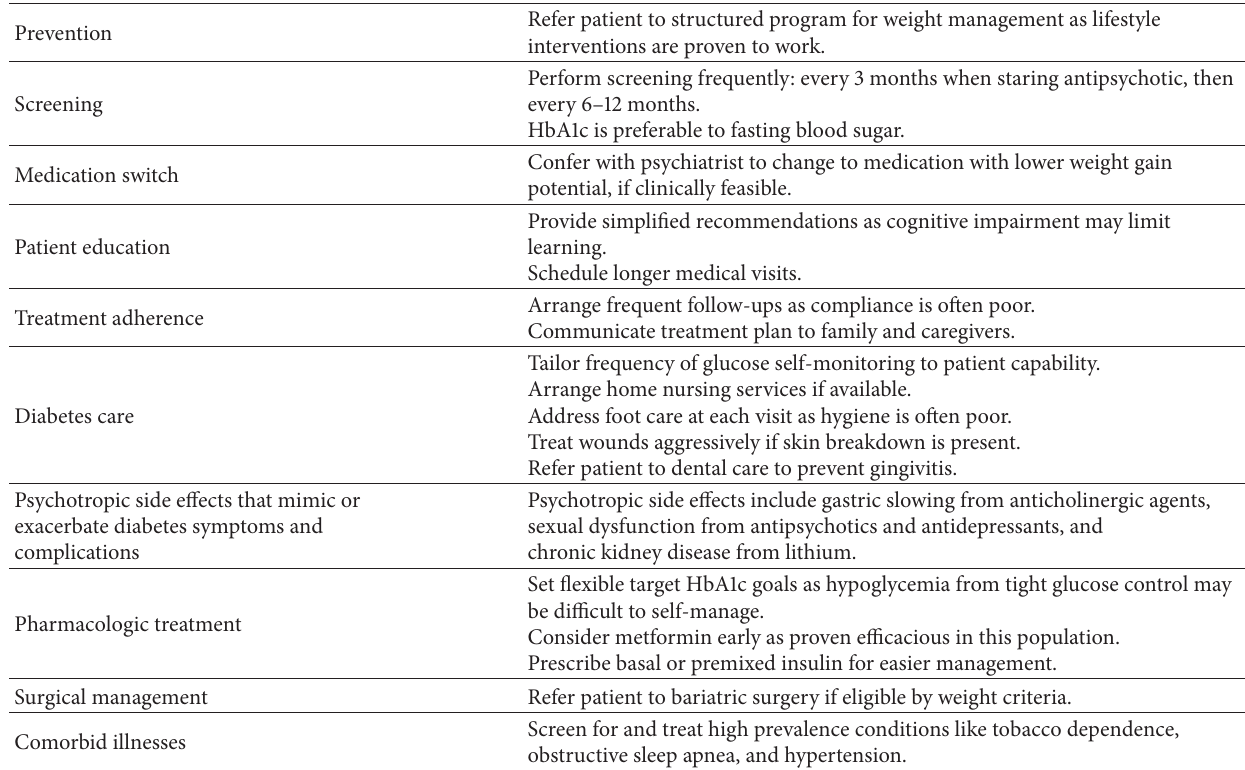
Table 1: Special considerations for diabetes treatment in schizophrenia